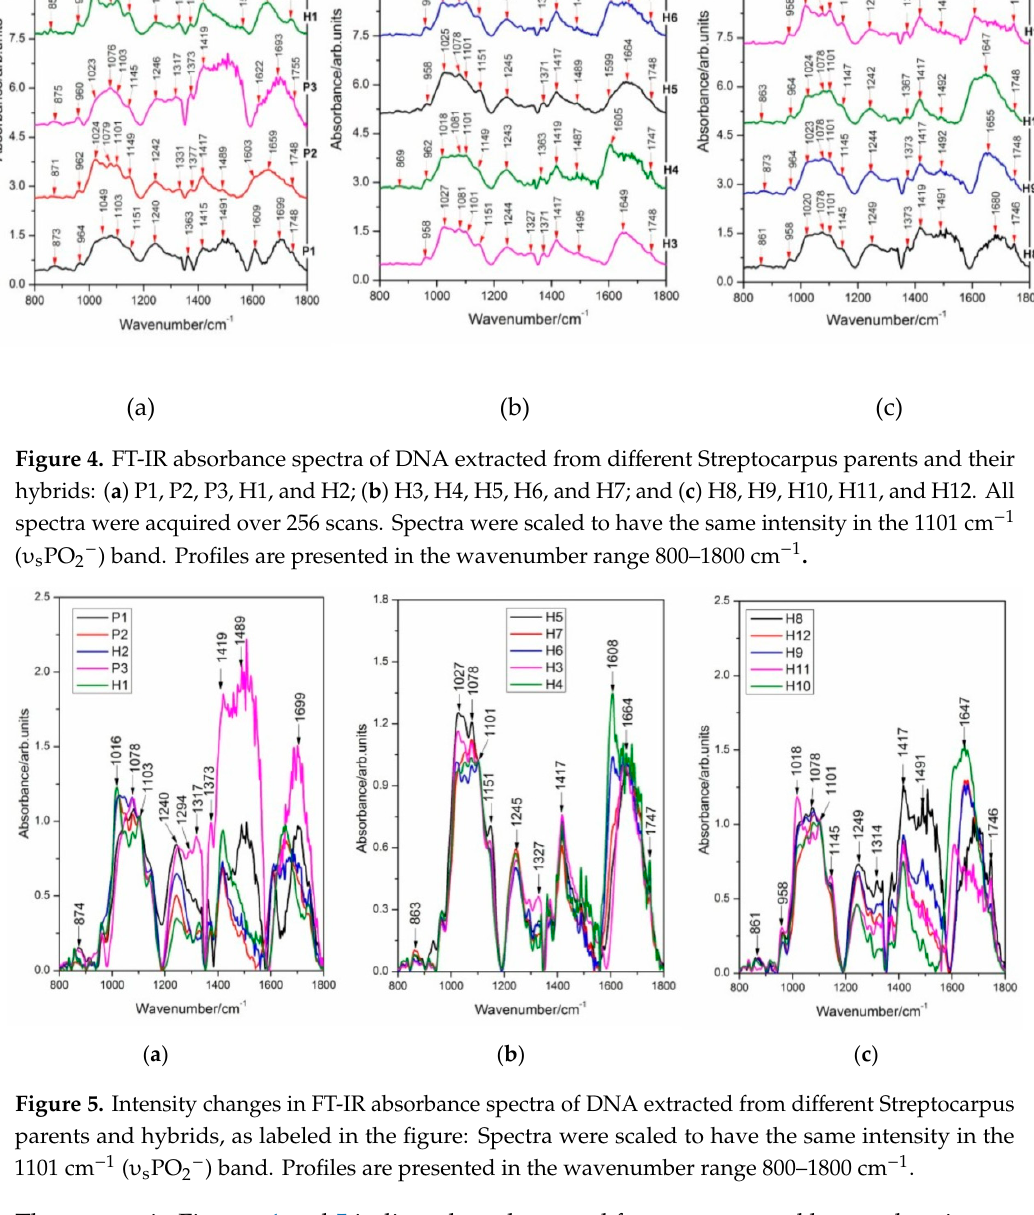
Table 4. Peak positions (cm − 1 ) and tentative assignments of FT-IR absorbance bands for DNA from the Streptocarpus P1 × P2 parental cross and their corresponding hybrids.